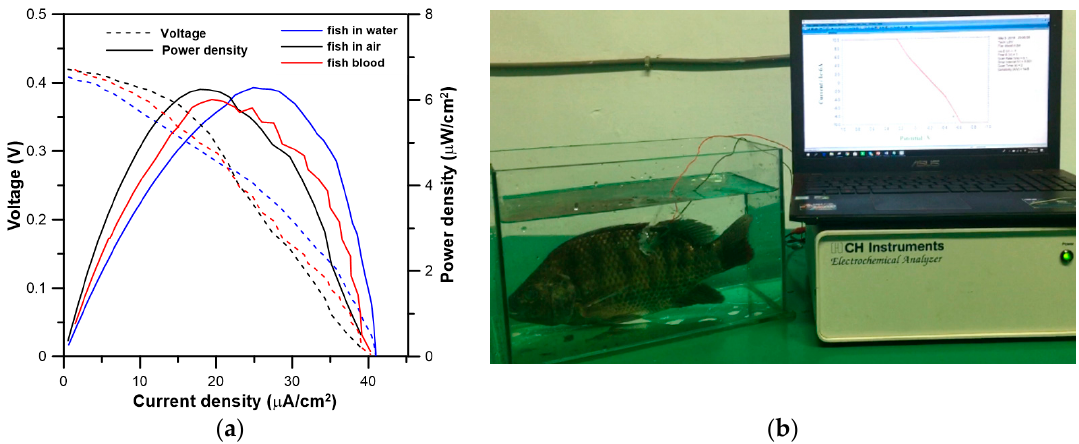
Figure 4. ( a ) Polarization curves, and current and power densities of the N-EFC operated in three testing conditions: Fish blood, fish in air, and fish in water, respectively. ( b ) An image of a free-swimming fish inserted with the N-EFC connected to an electrochemical analyzer in a fish tank at T w = 25 °C. (Fish blood, fish in air, and fish in water denoted as the power of the N-EFC generated from the blood withdrawn from fish, the fish with the N-EFC operated in air, and the fish with the N-EFC operated in water, respectively.).